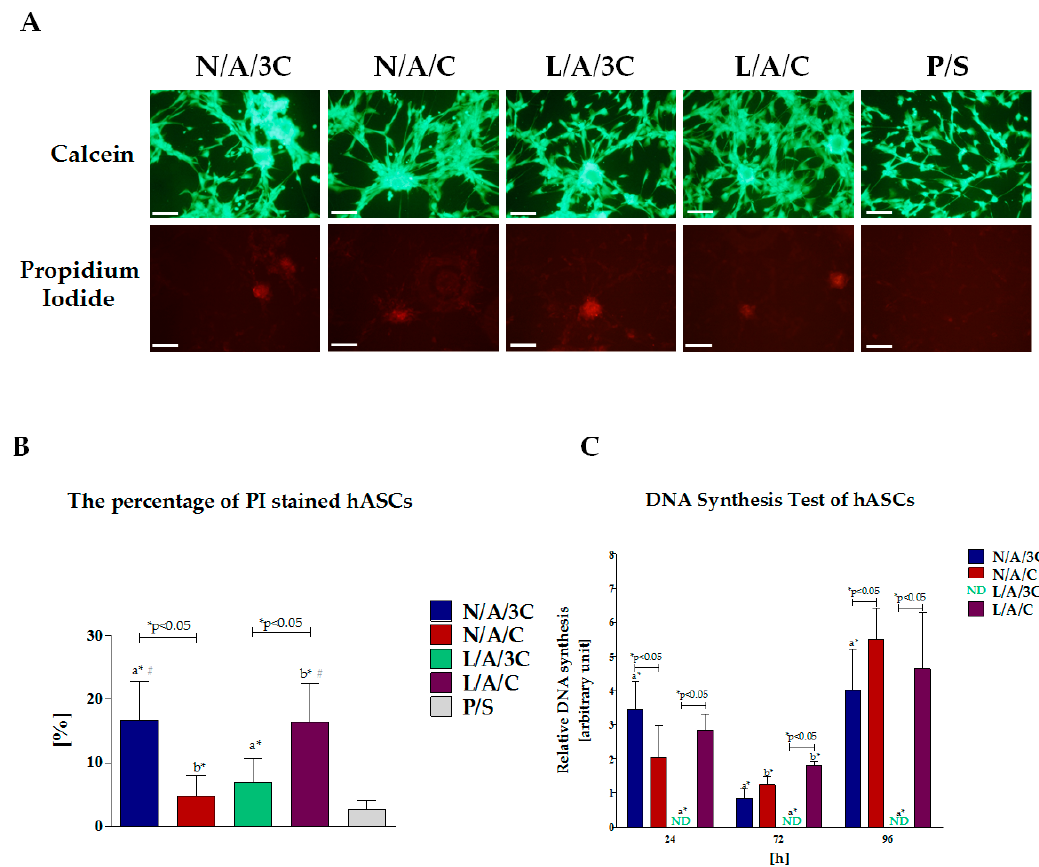
Figure 9. Cytotoxicity of biomaterials and influence of DNA synthesis in hASC cultures. Images of cells stained with calcein and propidium iodide ( A ), scale bar =200 µm; Comparative analysis of percentage of propidium iodide positive cells ( B ); Results of BrdU incorporation assay ( C ). Fold change in